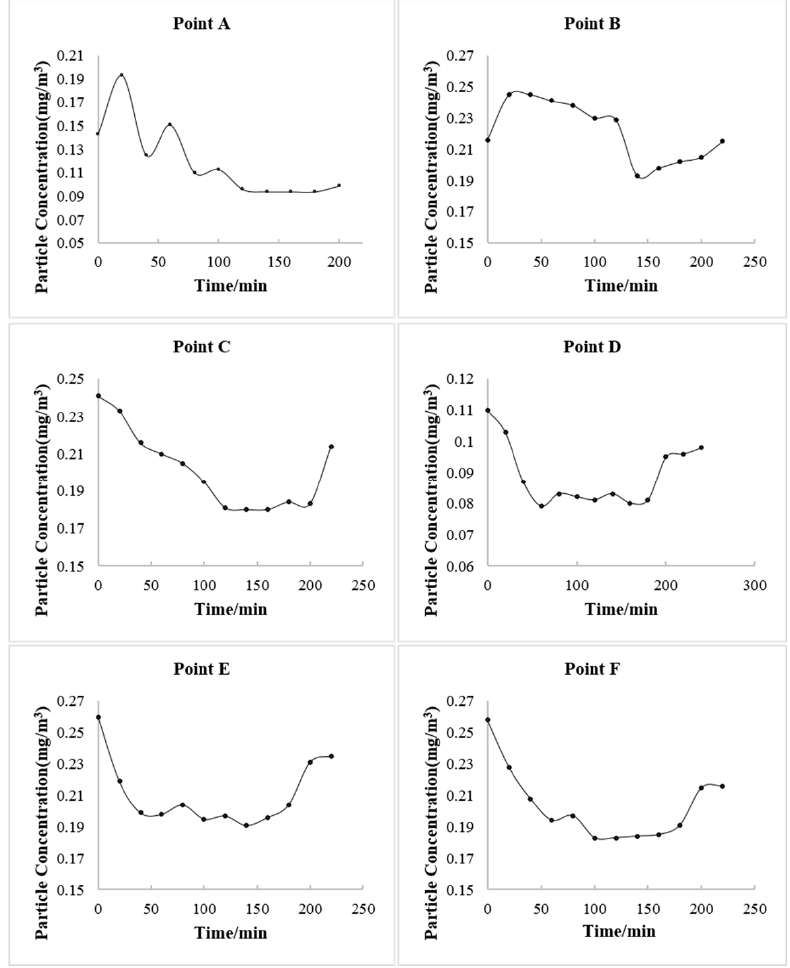
Figure 3. The changes of particle concentration over time at PM 10 in different points.